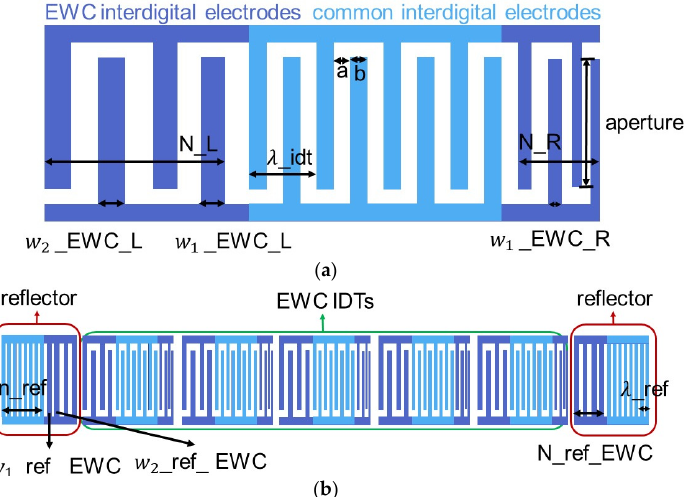
Figure 6. The structure of the phase shifter. ( a ) The structure of the EWC IDT. It contains the aperture, the number of the common interdigital electrode 𝑛_𝑖𝑑𝑡 , the period of IDT 𝜆_𝑖𝑑𝑡 , the width of common electrodes 𝑏 , the gap between each electrode 𝑎 , the number of the EWC electrodes at the left 𝑁_𝐿 , the number of the EWC electrodes at the right 𝑁_𝑅 , the width of EWC electrode at the left 𝑤_𝐸𝑊𝐶_𝐿 , and the width of EWC electrode at the right w_𝐸𝑊𝐶_𝑅 . ( b ) The structure of the phase shifter used by the EWC IDTs. It contains the parameters of the EWC IDTs, the period of the reflector 𝜆_𝑟𝑒𝑓 , the number of electrodes of the reflector 𝑛_𝑟𝑒𝑓 , the width of the EWC electrode of the reflector w_𝑟𝑒𝑓_𝐸𝑊𝐶 , and the number of the EWC electrodes of the reflector 𝑁_𝑟𝑒𝑓_𝐸𝑊𝐶 .